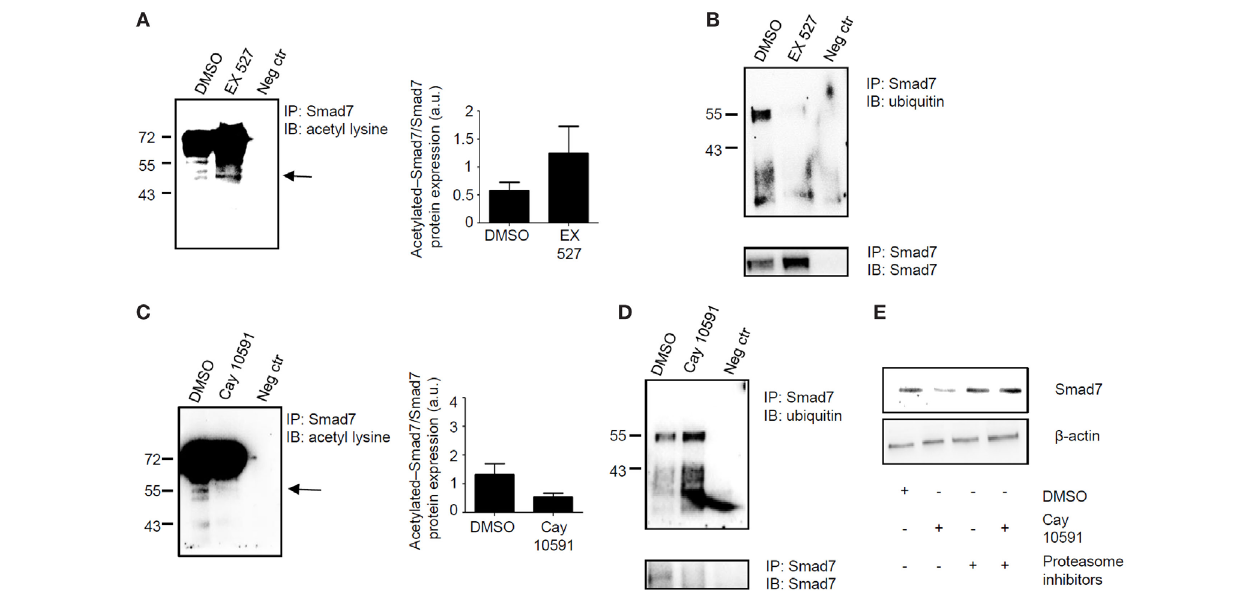
FigUre 4 | Sirt1 regulates the acetylation/ubiquitination status of Smad7. (a,B) Inhibition of Sirt1 in control lamina propria mononuclear cells (LPMC) increases Smad7 acetylation and reduces Smad7 ubiquitination. Total proteins extracted from control LPMC, cultured in the presence of Ex527 or dimethyl sulfoxide (DMSO) (vehicle), were immunoprecipitatated (IP) with Smad7 antibody or control antibody (neg ctr) and the blots were incubated with anti-acetyl-lysine antibody (a) or anti-ubiquitin antibody (B) . At the end, the blots were stripped and incubated with a Smad7 antibody recognizing a different epitope of that recognized by the antibody used for immunoprecipitation In panel (a) , arrow shows the specific band corresponding to acetylated Smad7; right panel shows the quantitative analysis of acetylated Smad7/Smad7 ratio as measured by densitometry scanning of Western blots. Values are expressed in arbitrary units (a.u.). The blots are representative of three separate experiments in which LPMC of three normal controls were used. (c,D) Activation of Sirt1 in inflammatory bowel disease (IBD) LPMC reduces Smad7 acetylation and increases Smad7 ubiquitination. Total proteins extracted from IBD LPMC, cultured in the presence of CAY10591 or DMSO, were IP with Smad7 antibody or control antibody (neg ctr) and the blots were incubated with anti-acetyl-lysine antibody (c) or anti-ubiquitin antibody (D) . At the end, blots were stripped and incubated with a Smad7 antibody recognizing a different epitope of that recognized by the antibody used for immunoprecipitation. In panel (c) , arrow shows the specific band corresponding to acetylated Smad7; right panel shows the quantitative analysis of acetylated Smad7/Smad7 ratio as measured by densitometry scanning of Western blots. Values are expressed in arbitrary units (a.u.). The blots are representative of three separate experiments in which LPMC of three IBD patients were used. (e) Representative blots showing Smad7 and β -actin in total proteins extracted from IBD LPMC pre-incubated or not with proteasome inhibitors (Mg112 and Mg132) and then cultured in the presence of DMSO or Cay10591 for 8 h. The blots are representative of three separate experiments in which LPMC of three IBD patients were